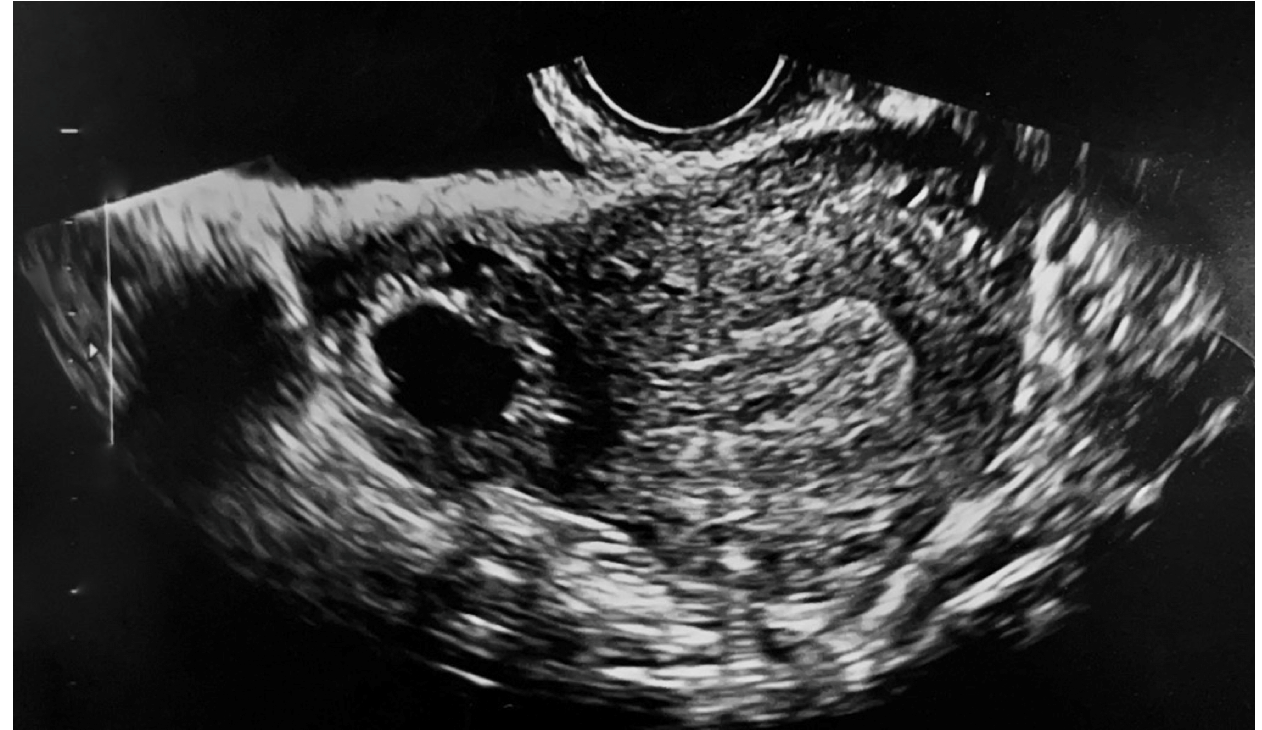
Figure 1. Transvaginal ultrasound showing the interstitial pregnancy.